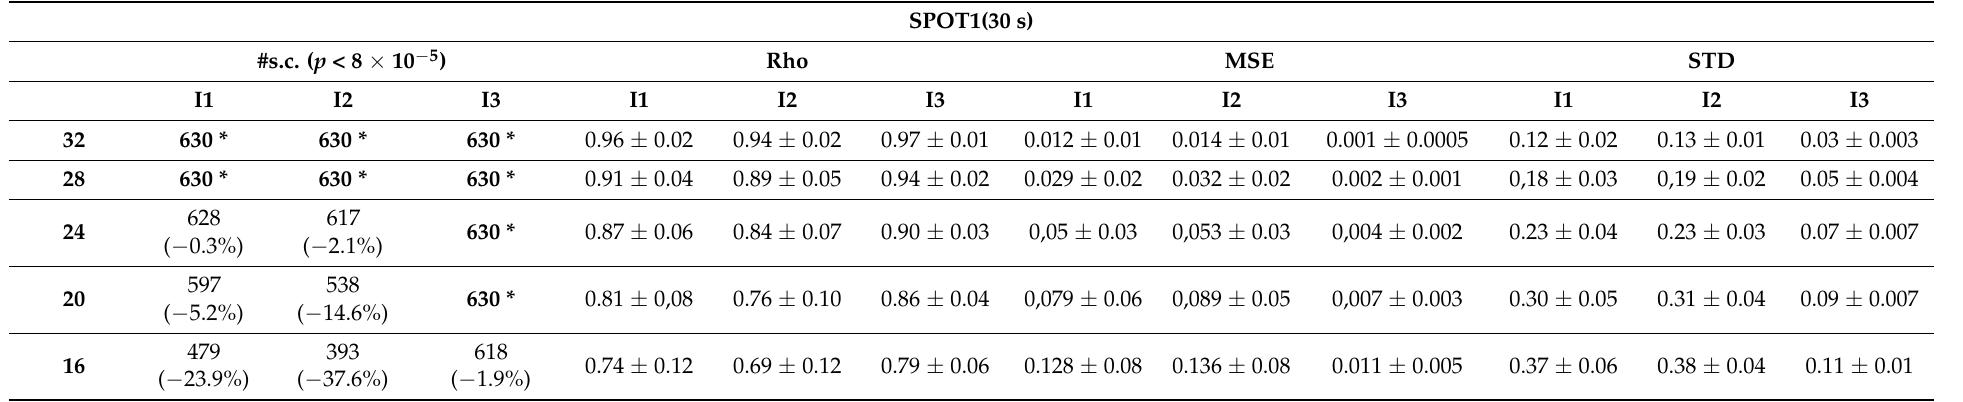
Table 1. Number of significant correlations (#s.c.) and eventual decreasing as percentage of the total number of combinations (630), median ± std of rho, MSE, and STD for the three indices (I1, I2, I3) and the five subgroups of subjects (32, 28, 24, 20, 16) during SPOT1.